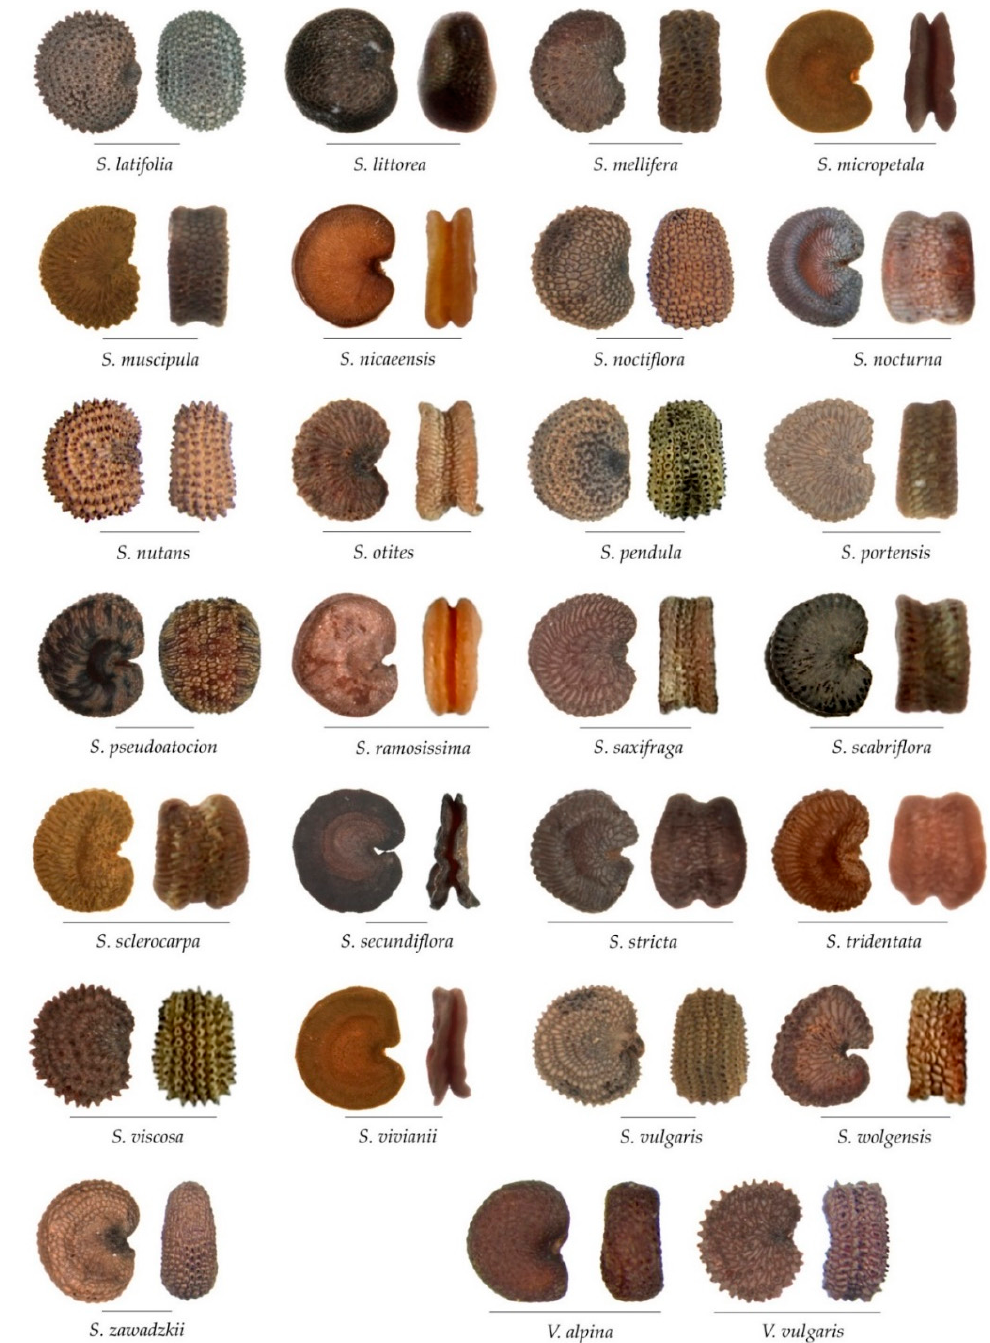
Figure A2. Representative photographs of the lateral and dorsal views of the seeds for the species of Atocion (A.) , Silene (S.) and Viscaria ( V .) used in this work. Bars represent 1 mm.